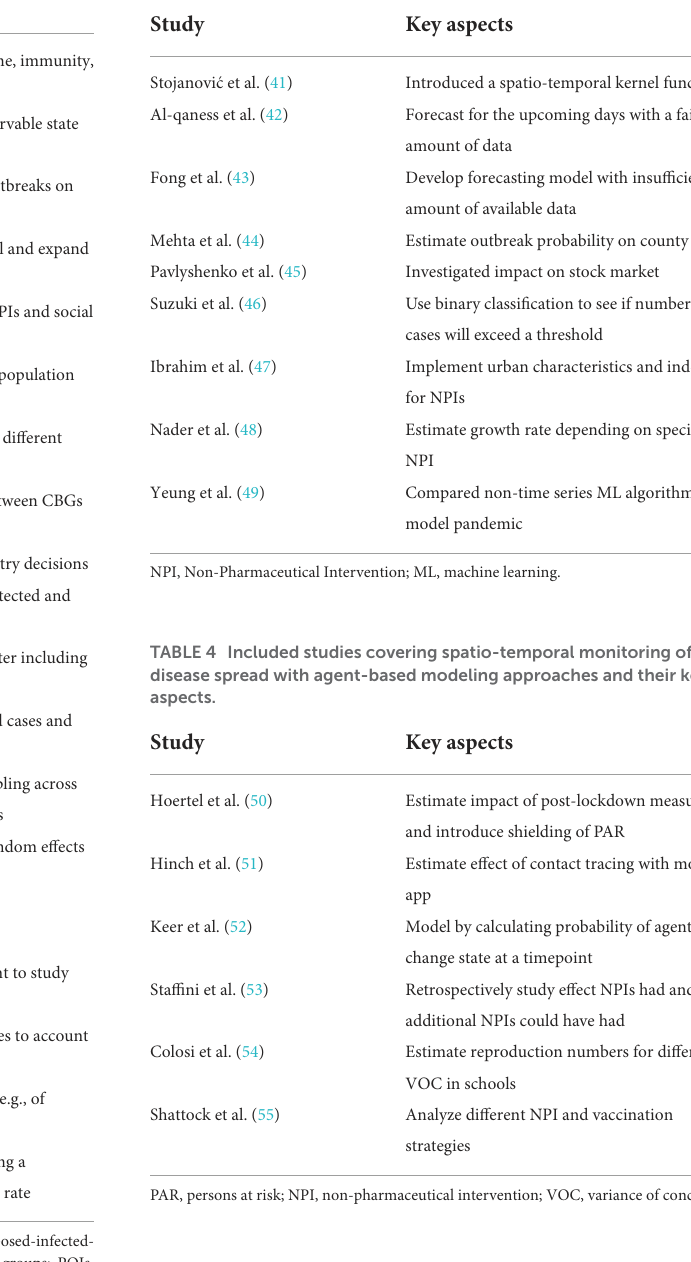
TABLE 3 Included studies covering spatio-temporal monitoring of disease spread with machine learning and Bayesian models and their key aspects.